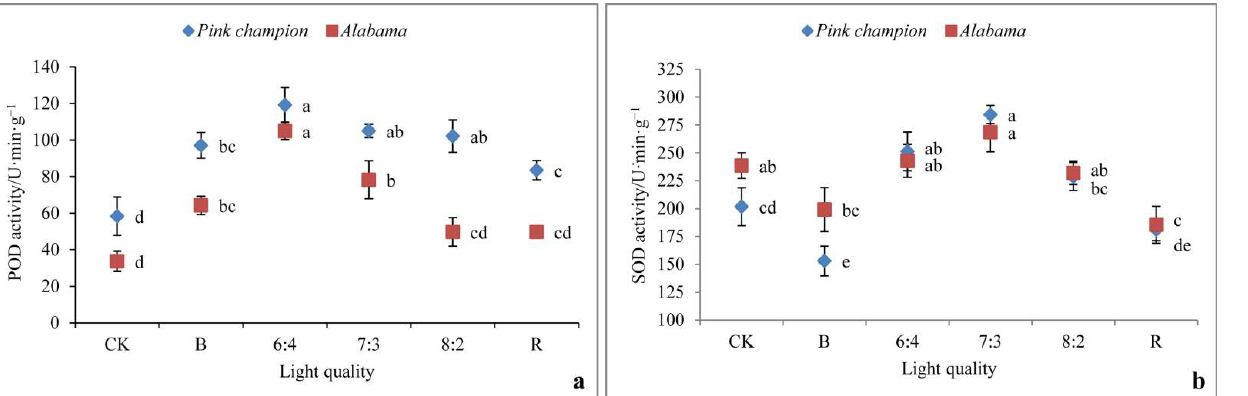
Figure 7. Effects of different light qualities on POD ( a ) and SOD ( b ) activity of Anthurium ‘Pink Champion, Alabama’. The statistical analysis has been carried out separately for each cultivar.